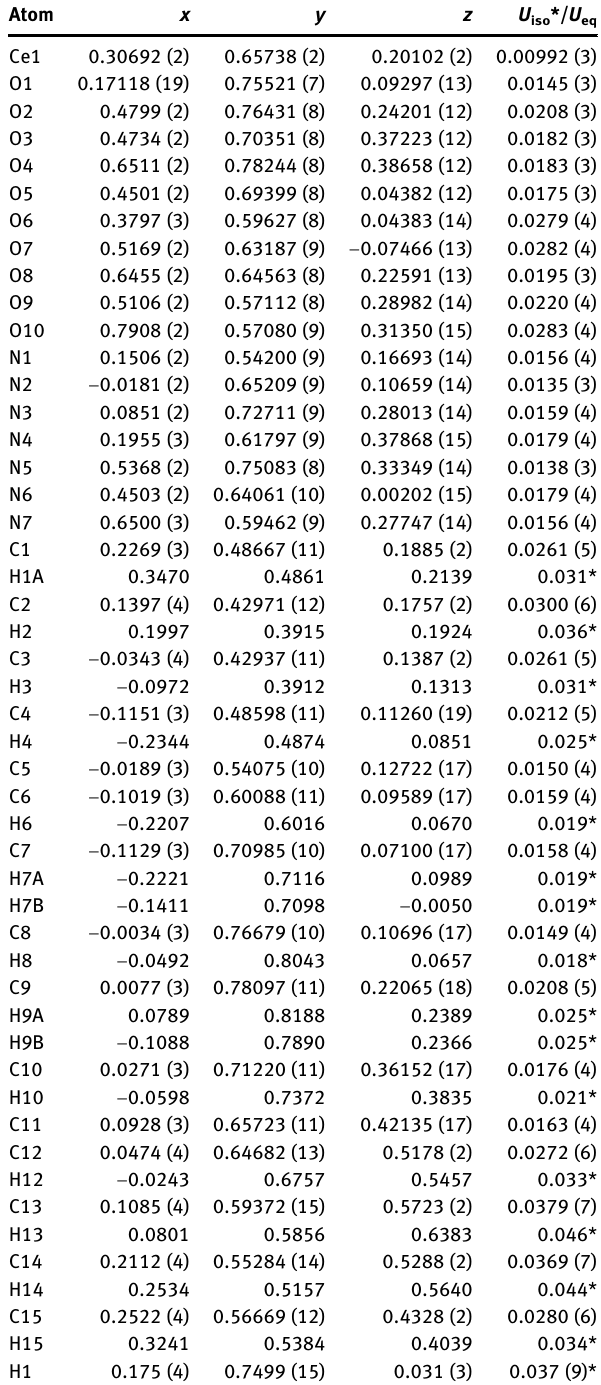
Table  : Fractional atomic coordinates and isotropic or equivalent isotropic displacement parameters (Å 